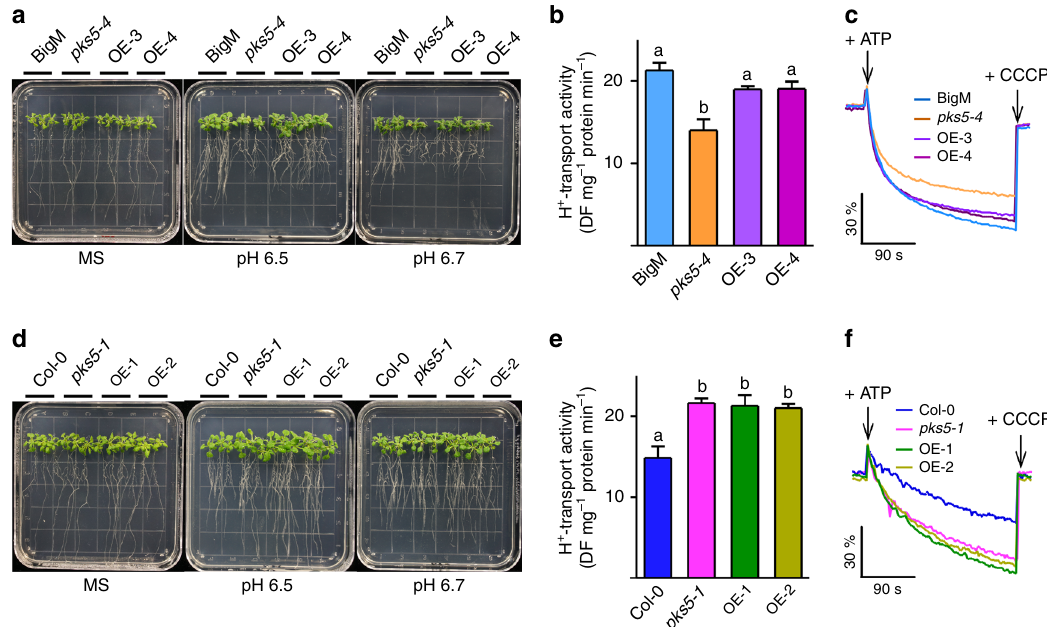
Fig. 6 Overexpression of 14-3-3 rescues the phenotypes of pks5-4 . a Alkaline sensitive analysis of BigM, pks5-4 , and two independent transgenic lines (OE- 3 and OE-4) expressing Flag-HA-14-3-3 λ driven by the 35S promoter in the pks5-4 background. Seven-day-old seedlings were transferred to pH 6.5 or 6.7 MS medium adjusted using NaHCO 3 . Photographs were taken 10 days after seedling transfer. b Comparison of PM H + -ATPase activity in BigM, pks5-4 , OE-3, and OE-4. Plasma membrane vesicles were puri fi ed from 5-week-old seedlings grown in soil treated with 250mM NaCl for 3 days. Error bars represent SD; p ≤ 0.05, Student ’ s t -test; n = 3; signi fi cant differences are indicated by different lowercase letters. c Timely varying curves of PM H + -ATPase activity in BigM, pks5-4 , OE-3, and OE-4. d Alkaline tolerance analysis of Col-0, pks5-1 , and two independent transgenic lines (OE-1 and OE-2) expressing Flag-HA-14-3-3 λ driven by the 35S promoter in the pks5-1 background. Photographs were taken 10 days after seedling transfer. e Comparison of PM H + -ATPase activity in Col-0, pks5-1 , OE-1, and OE-2. Error bars represent SD; p ≤ 0.05, Student ’ s t -test; n = 3; signi fi cant differences are indicated by different lowercase letters. f Timely varying curves of PM H + -ATPase activity in Col-0, pks5-1 , OE-1, and OE-2. Source data of b , c , e , and f are provided in the Source Data fi